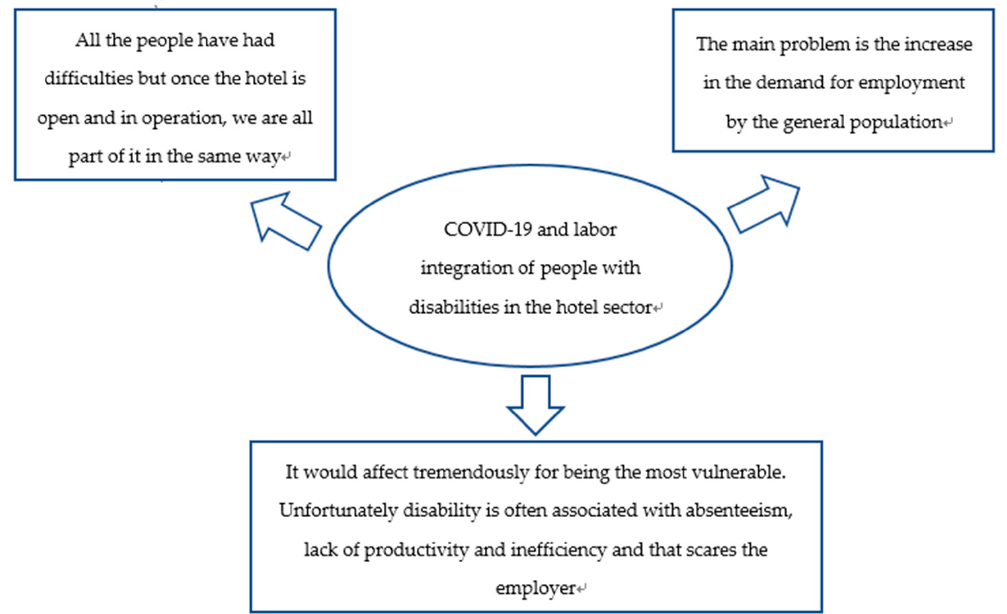
Figure 4. How do you think the COVID-19 crisis may be and will affect the labor integration of people with disabilities in the hotel sector?